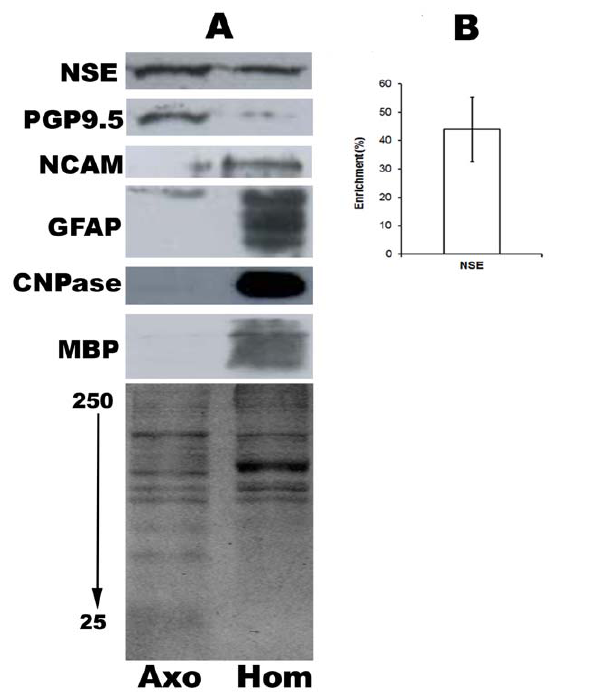
Figure 2. Detergent-free recovery of soluble axonal proteins. Optic nerve homogenates and axoplasm-enriched samples were separated using SDS-PAGE and coomassie stained, which revealed alternative populations of proteins (A). Immunoblotting was performed for a series of axonal and glial markers. Soluble (GFAP and CNPase) and membrane-bound (MBP) glial markers were significantly depleted in axoplasm samples (A). In contrast, the soluble axonal markers NSE and PGP9.5 were recovered and enriched (A&B). The membrane-bound axonal marker NCAM was not similarly recovered (A). Images are representative of at least 3 separate axoplasm preparations. Densito- metric analysis of NSE percentage recovery versus homogenate is presented as 6 S.E.M